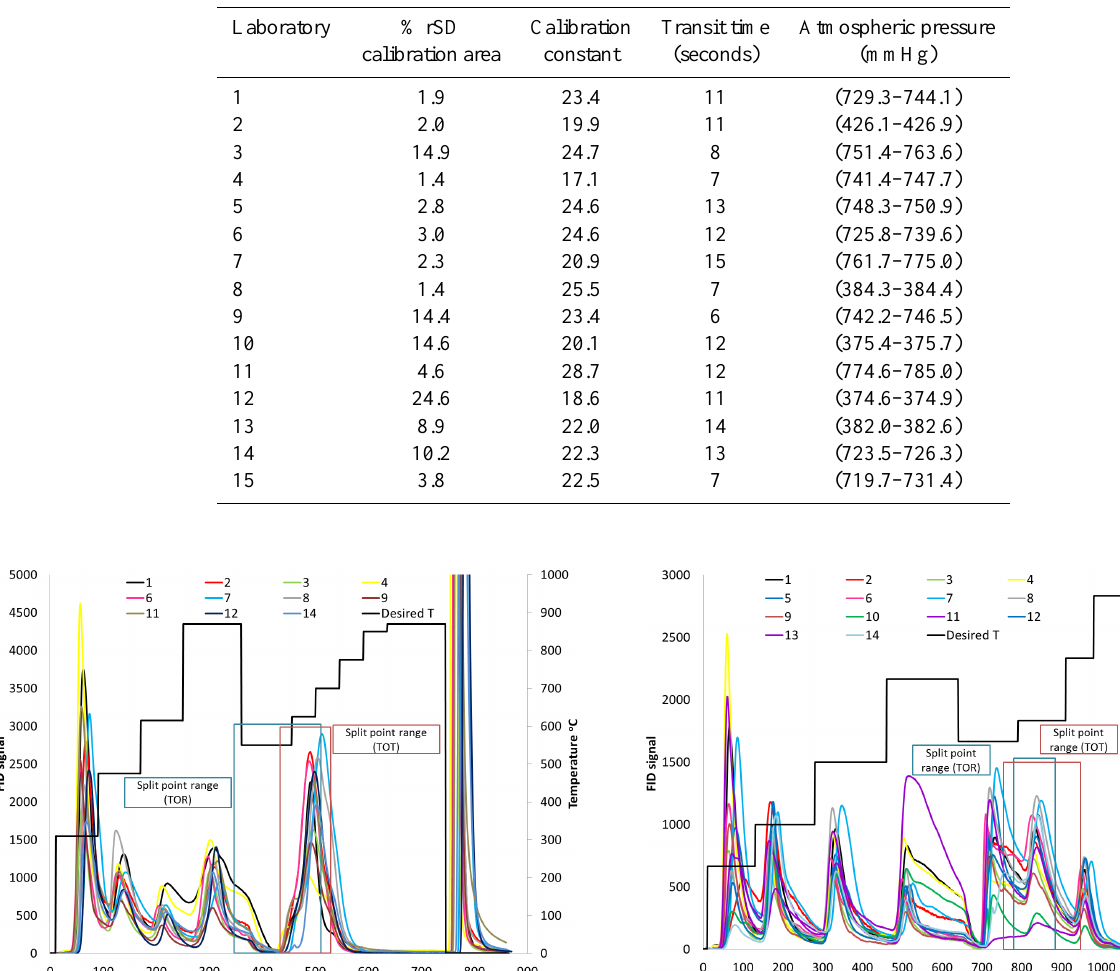
Table 5. Relative standard deviations (% rSD) of calibration area for all analyses per participant. Instrument specific characteristics, calibra- tion constant, transit time and atmospheric pressure.